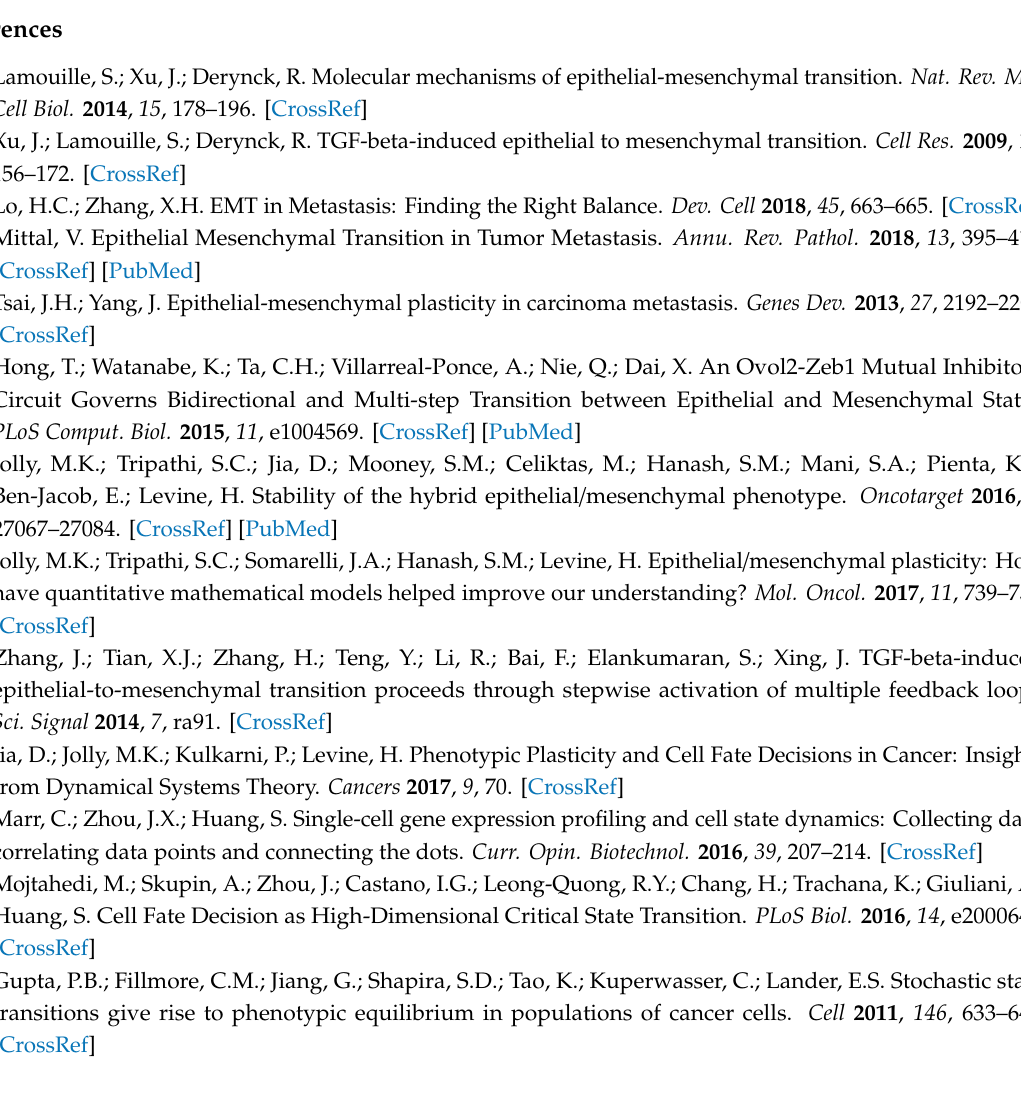
Methods S1–S3: Detailed information about the cell state transition mathematical model, Table S1: Fractional cell division values estimated from the model, Table S2: Fractional state transition values estimated from the model, Table S3: Information about various antibodies used in the experiments, Table S4: Sequences of the primers used in Real-time PCR, Figure S1: Schematic representation of the state transition model, Figure S2: Number of nearest neighboring cells to each cell type, Figure S3: Migration assay, Figure S4: E ff ect of EGF on cell viability and cell death, Figure S5: Population distribution of cells estimated at 3 h interval in the period of 24 to 36 h post EGF treatment, Figure S6: State transition trajectories of cells treated with 25 ng / mL EGF, Figure S7: Results of the null model for 10 ng / mL EGF treated cells, Figure S8: Dynamics of phospho-EGFR and total EGFR measured by Flow cytometry, Figure S9: Temporal dynamics of phospho-FAK, Figure S10: E ff ect of gefitinib on cell viability, Figure S11: E ffi ciency of cell type classification through machine learning, Figure S12: Standard curve to determine the linear regime of fluorescence-based plate reader assay, Figure S13: Pareto front and the objective function distribution of the state transition model for 10 ng / mL EGF treated cells, Figure S14: Fractions of each cell type predicted by the state transition model for 10 ng / mL EGF treated